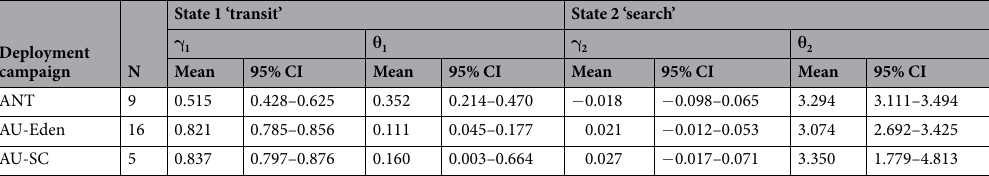
Table 3. Posterior sample means and 95% credible intervals (CIs) for movement parameters estimated using a hierarchical state-space behavioural switching model. Turning angles ( θ ) are given in radians, the movement persistence parameter ( γ ) is the correlation in speed and direction. Subscripts indicate behavioural state. The state-space model was run on each campaign separately, with N indicating each sample size (number of whales).